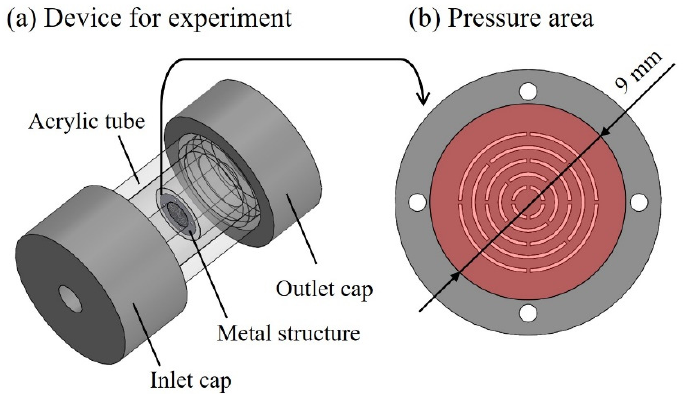
Figure 11. Overview of the device for the experiment. ( a ) The metal structure was fixed inside the device, and the hydrodynamic force was applied. The metal structure was fixed to an acrylic tube with an inner diameter of 9 mm. ( b ) Pressure was applied to the metal structure in a 9-mm-diameter area around the center.